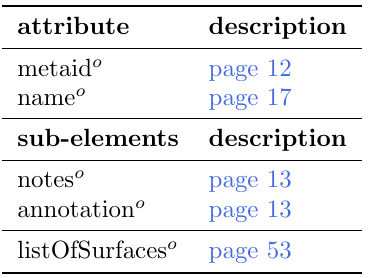
Table 2.23: Attributes and nested elements for plot3D. o denotes optional elements and attributes.